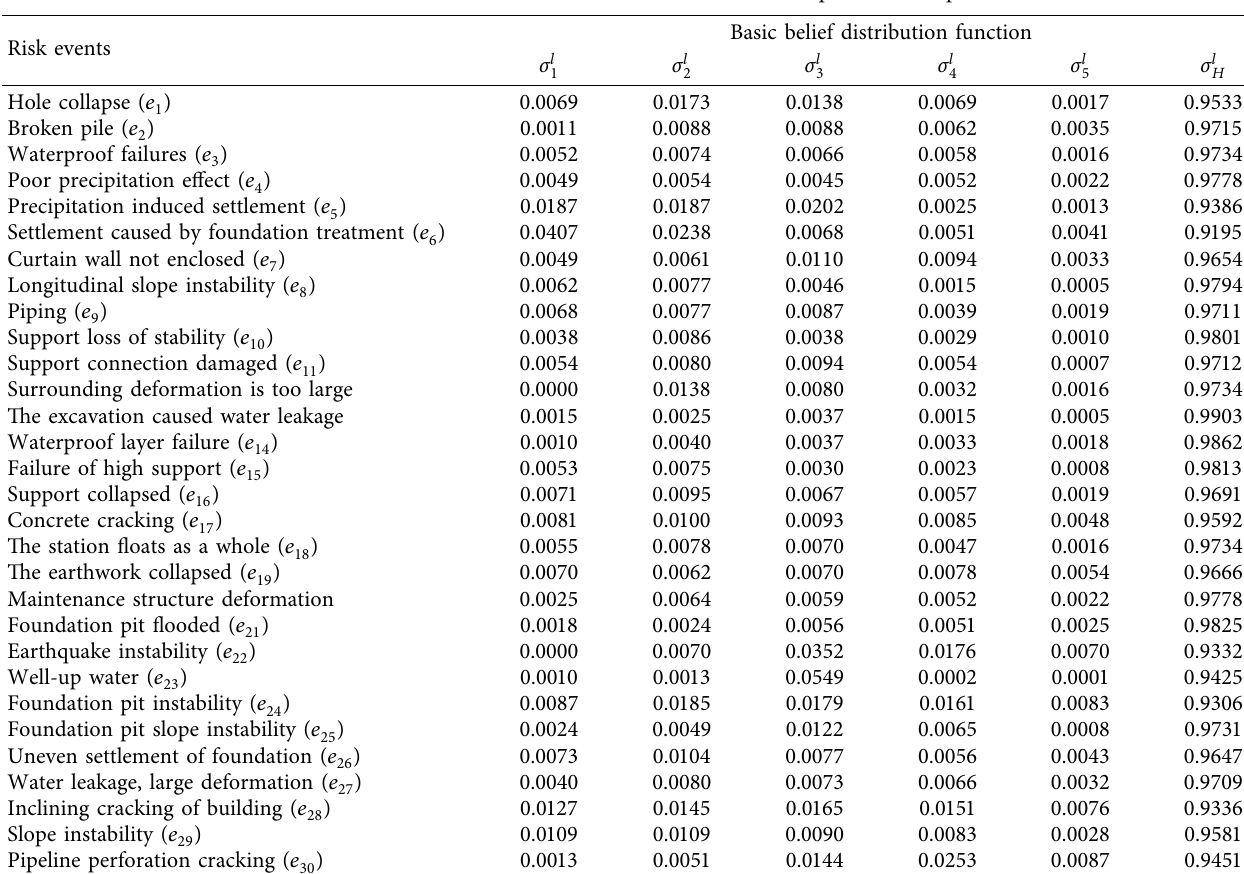
Table 16: Belief distribution function list of all risk events in metro deep foundation pit construction.